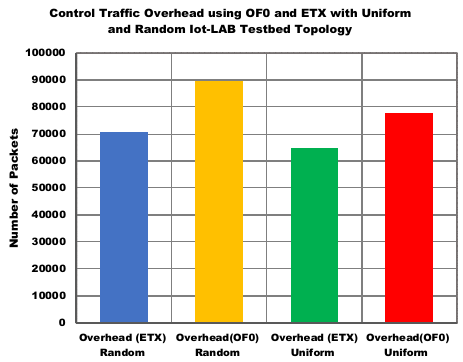
Figure 9. Comparison between total control traffic overhead in IoT-LAB testbed using OF0 and ETX with random and uniform network topology.